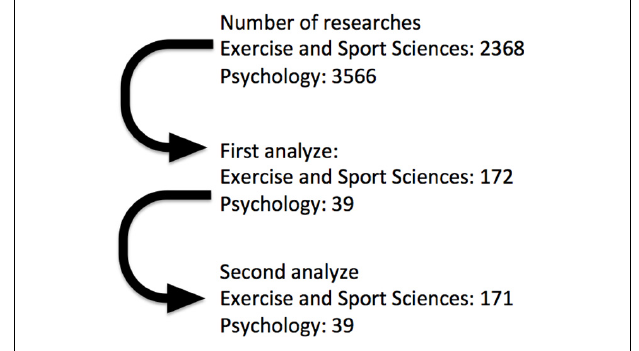
FIGURE 1 | Research selection